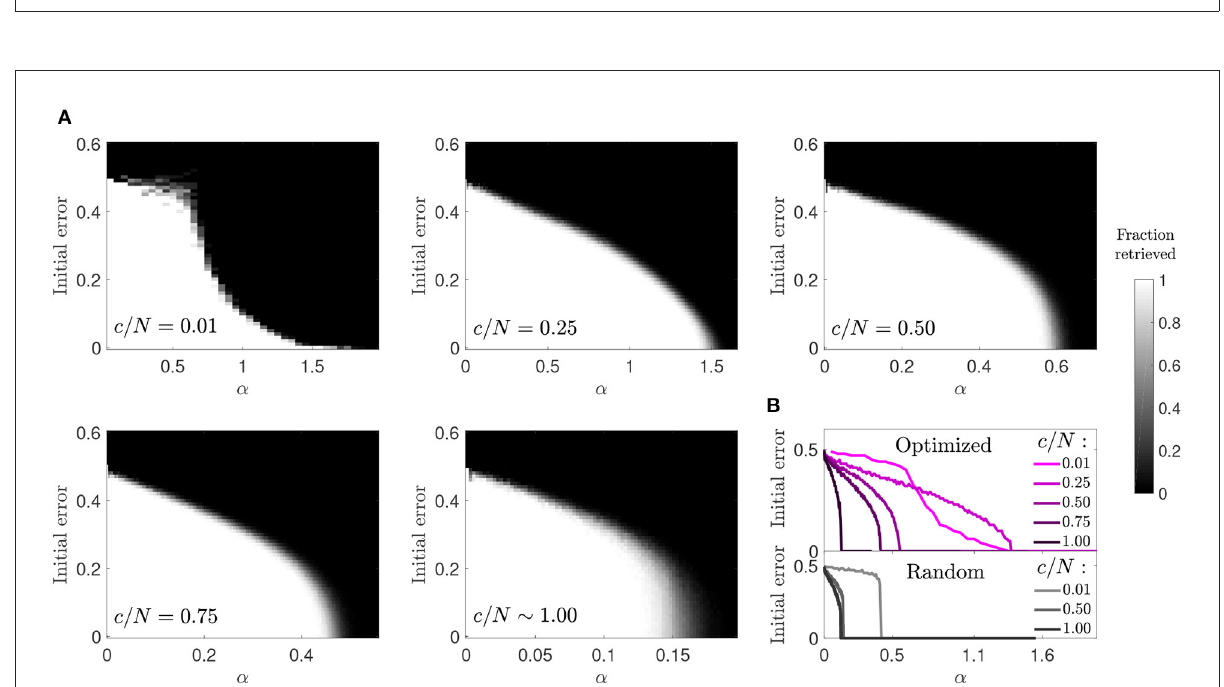
FIGURE4 Reduced basin of attraction in optimized networks with diluted connectivity. (A) Fraction of patterns that a network of N = 2,000 can successfully retrieve (gray-scale), relative to the initial error. (B) Phase transition curves from (A) condensed in a single plot (top) together with similar curves corresponding to a random network (bottom). Connectivity is color